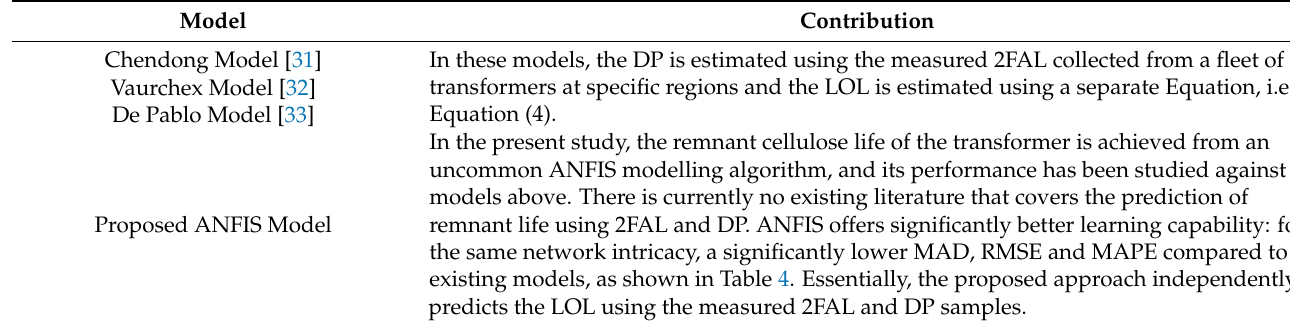
Table 5. Comparison of present study to previous